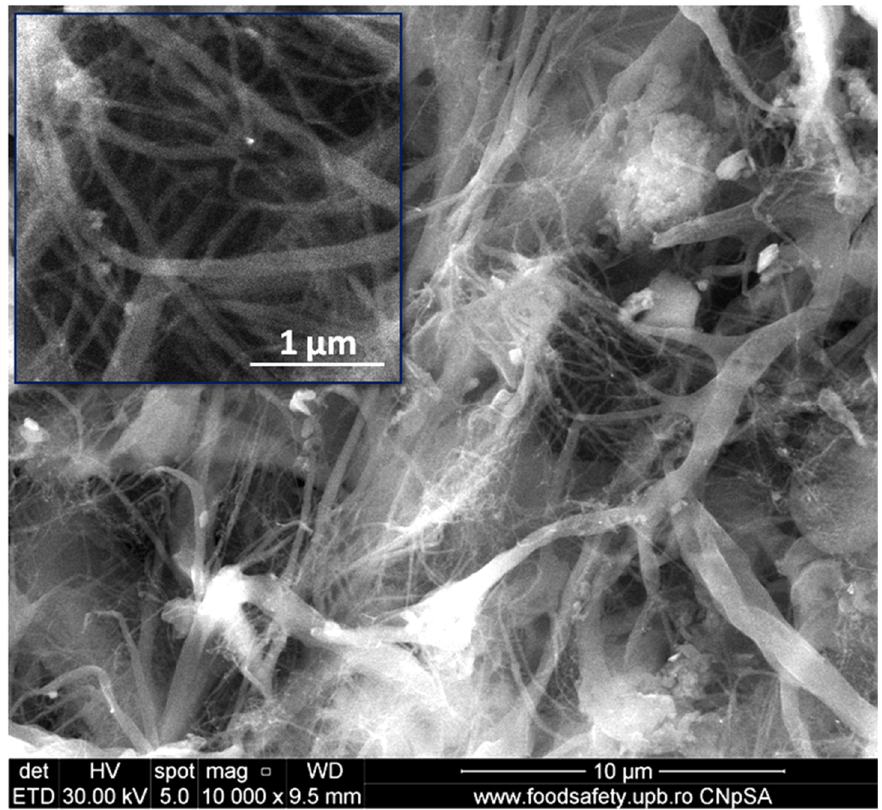
Figure 2. SEM image of microfibrillated cellulose after freeze-drying and milling. Many entangled and agglomerated cellulose nanofibers were noticed in Figure 2.